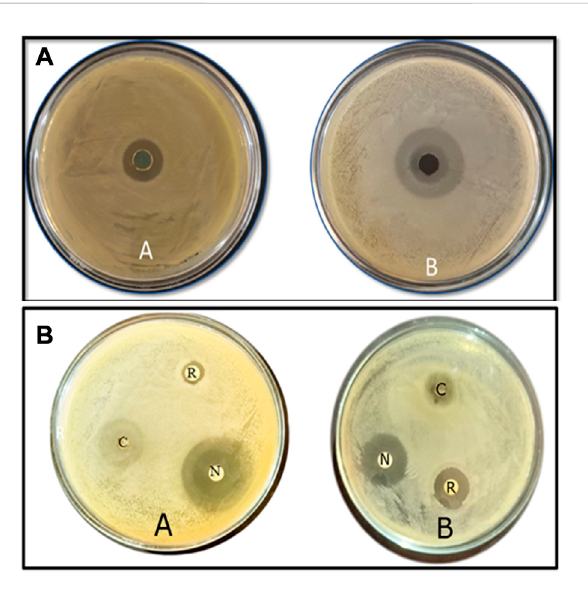
FIGURE 7 Antibacterial activities of biogenic CuO nanoparticles at 50 μ g mL − 1 the concentrationagainst (A) Xanthomonas Sp. (B) E. coli using (a) well diffusion method (b) disc diffusion method along